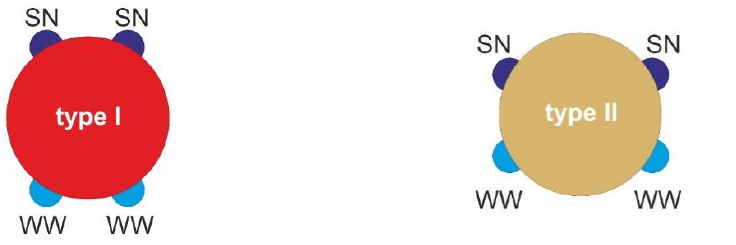
Figure 1. Patchy particles type I ( left ) and patchy particles type II ( right ). Strong and narrow SN patches (deep blue) and weak and wide WW patches (light blue) are distributed for both types in a sequence SN-SN-WW-WW, but for PPs type I as 60-120-60-120 degrees, while for PPs type II as 120-60-120-60 degrees. The corresponding monomers are in red (type I) and gold (type